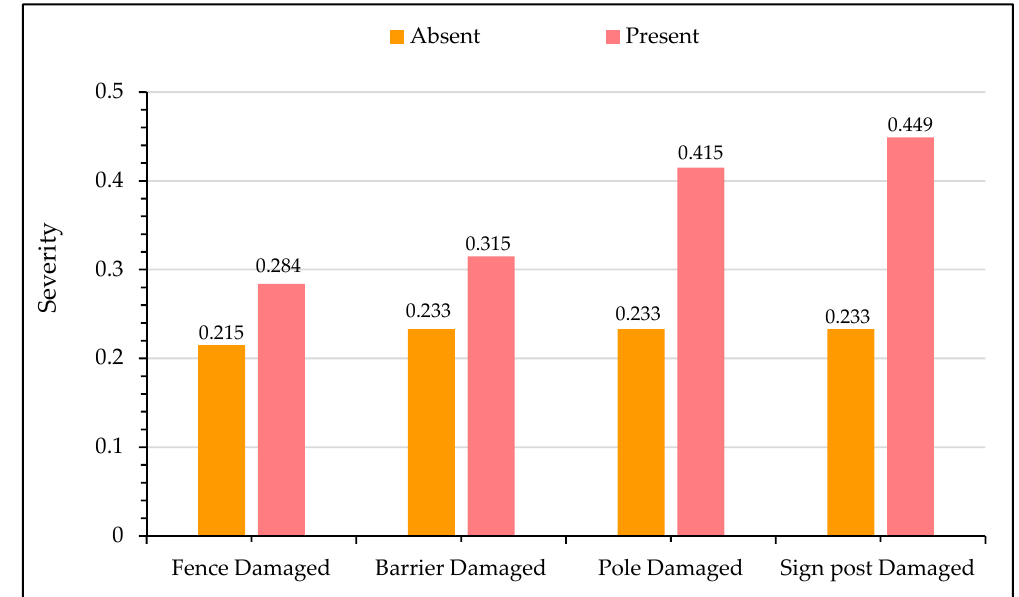
Figure 9. Effect of on-site damage condition on crash severity. Figure 9. E ff ect of on-site damage condition on crash severity.